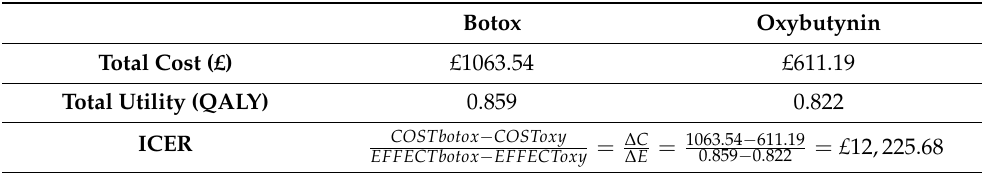
Table 3. Results summary.